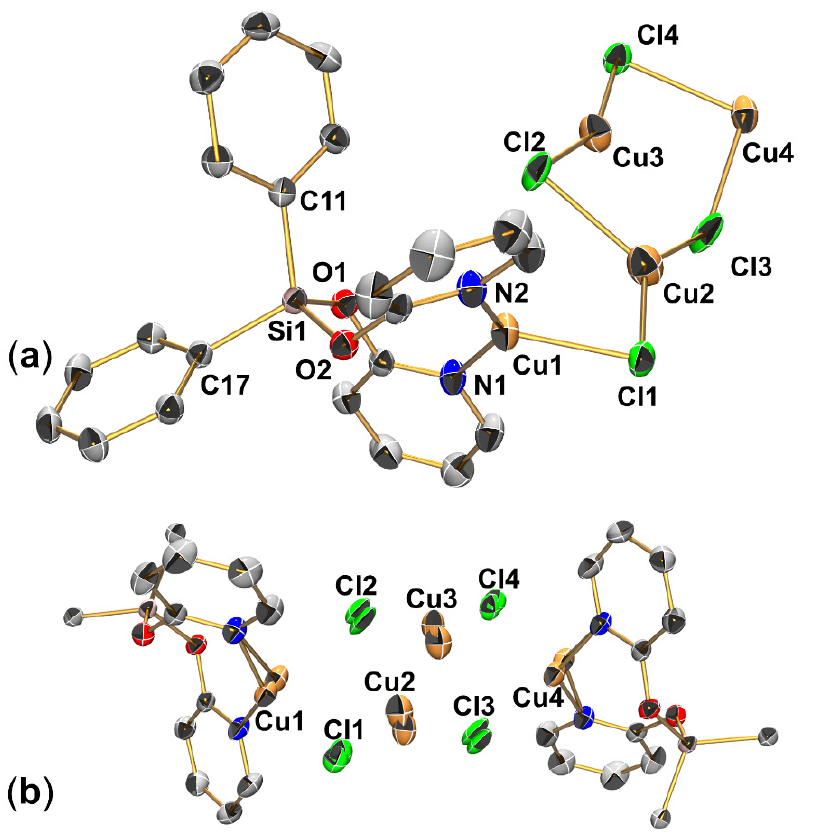
Figure 12. Molecular structure of 5 4 in its THF solvate 5 4 · (THF) 2 with thermal displacement ellipsoids at the 50% probability level and labels of selected non-hydrogen atoms. Section ( a ) shows the asymmetric unit, section ( b ) shows the central part of the molecule with positions of the Cu and Cl atoms, which result from disorder by symmetry. For each group of two Cu or Cl atoms, the atom labels are located next to the atom which is part of the asymmetric unit. (The molecule is located on a center of inversion. Only the periphery, the two Ph 2 Si(pyO) 2 motifs, adhere to this symmetry, whereas the central Cu 4 Cl 4 part appears disordered and its Cu and Cl atoms can be refined in two positions. As there had been no superstructure reflections in the data set, which would hint at a larger unit cell, and refinement in space group P 1 did not eliminate this disorder, a selected set of the Cu and Cl atoms was chosen as a possible actual asymmetric unit.) Selected interatomic distances (Å) and angles (deg) for 5 4 : Si1–O1 1.649(2), Si1–O2 1.650(2), O1–Si1–O2 111.92(7), C11–Si1–C17